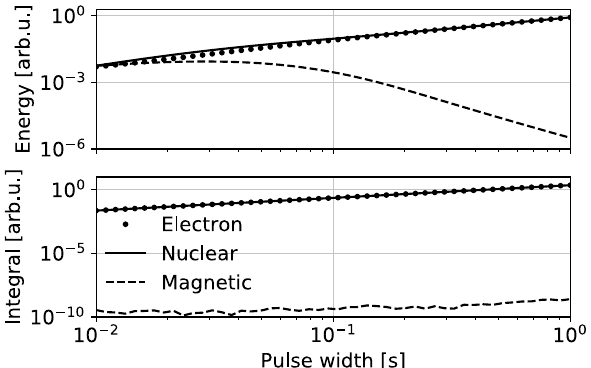
Figure 3. Energy and absolute value of the integral over temporal response of the co-magnetometer to the Lorentzian pulses of different width and coupling origin: electron nonmagnetic (dotted lines), nuclear nonmagnetic (solid lines), and magnetic (dashed lines) spin perturbations. Presented results are based on numerical calculation of the 200-s long co-magnetometer responses to the different-origin pulse perturbations. The shape of the pulses is given by Eq. (13) and is centred at t 0 = 100 s, i.e., the centre of the simulation region. For all types of pulses, we assume the same amplitude given in the effective pseudo-magnetic field